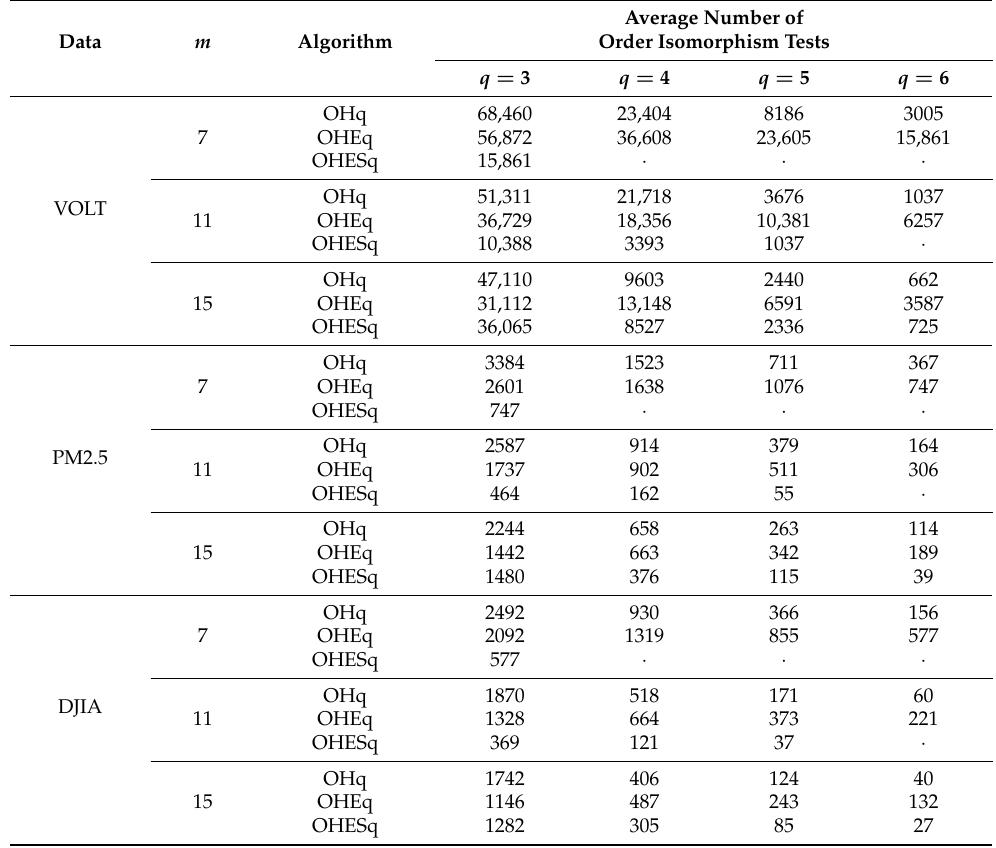
Table 3. Comparison of the average numbers of order isomorphism tests for VOLT, PM2.5, and DJIA